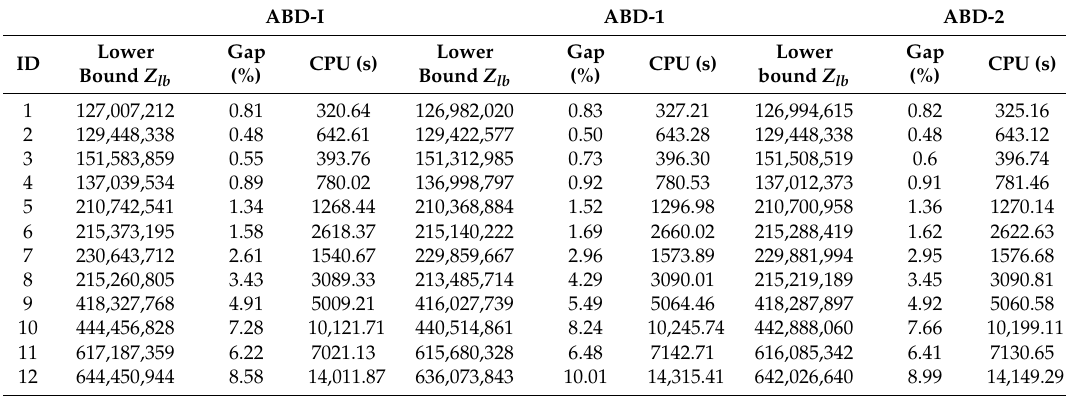
Table 7. Effectiveness of valid inequality cuts in terms of lower bound, optimality gap, and CPU